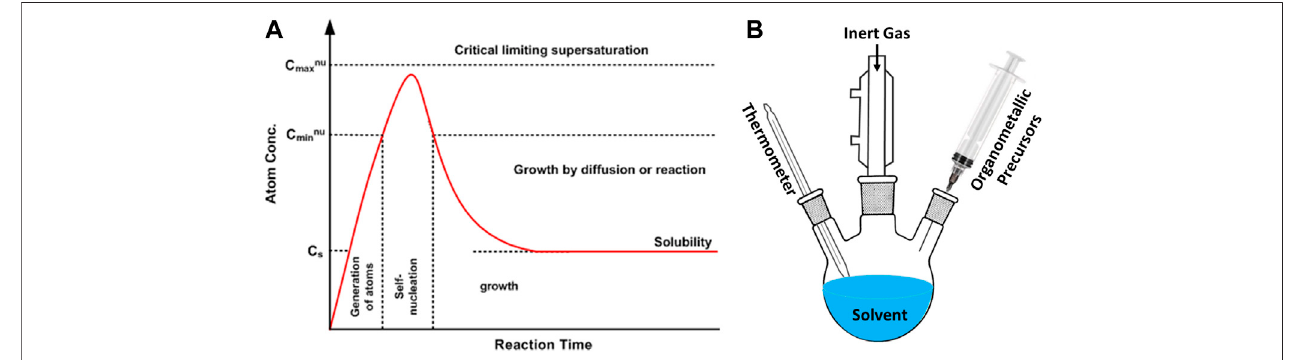
FIGURE 9 | (A) Kinetic and growth of nanocrystal of semiconductor crystals and (B) the hot injection setup (Murray et al., 2000).